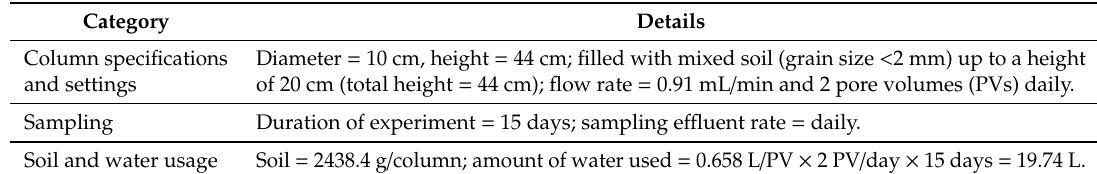
Table 3. Physicochemical properties of soil samples used in column ‐ leaching test.